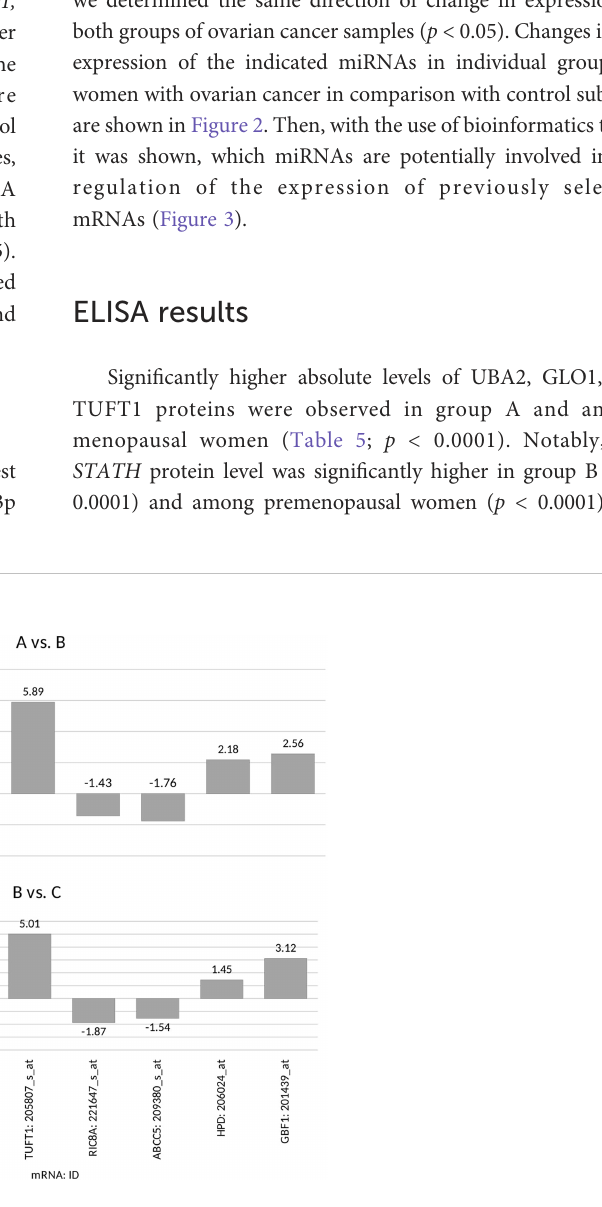
FIGURE 1 Microarray expression pro fi le of genes associated with drug resistance differentiating between the ovarian cancer samples (groups A and B) from control samples (group C) (p <0.05) for: UBA2 , ubiquitin-like modi fi er-activating enzyme 2; GLO1 , glyoxalase I; STATH , statherin; TUFT1, tuftelin 1; RIC8A , RIC8 guanine nucleotide exchange factor B; ABCC5 , ATP-binding cassette subfamily C member 5; HPD , 4-hydroxyphenylpyruvate dioxygenase; GBF1 , Golgi brefeldin A-resistant guanine nucleotide exchange factor 1; (+), overexpression in comparison with the control ( – );, downregulation in comparison with the